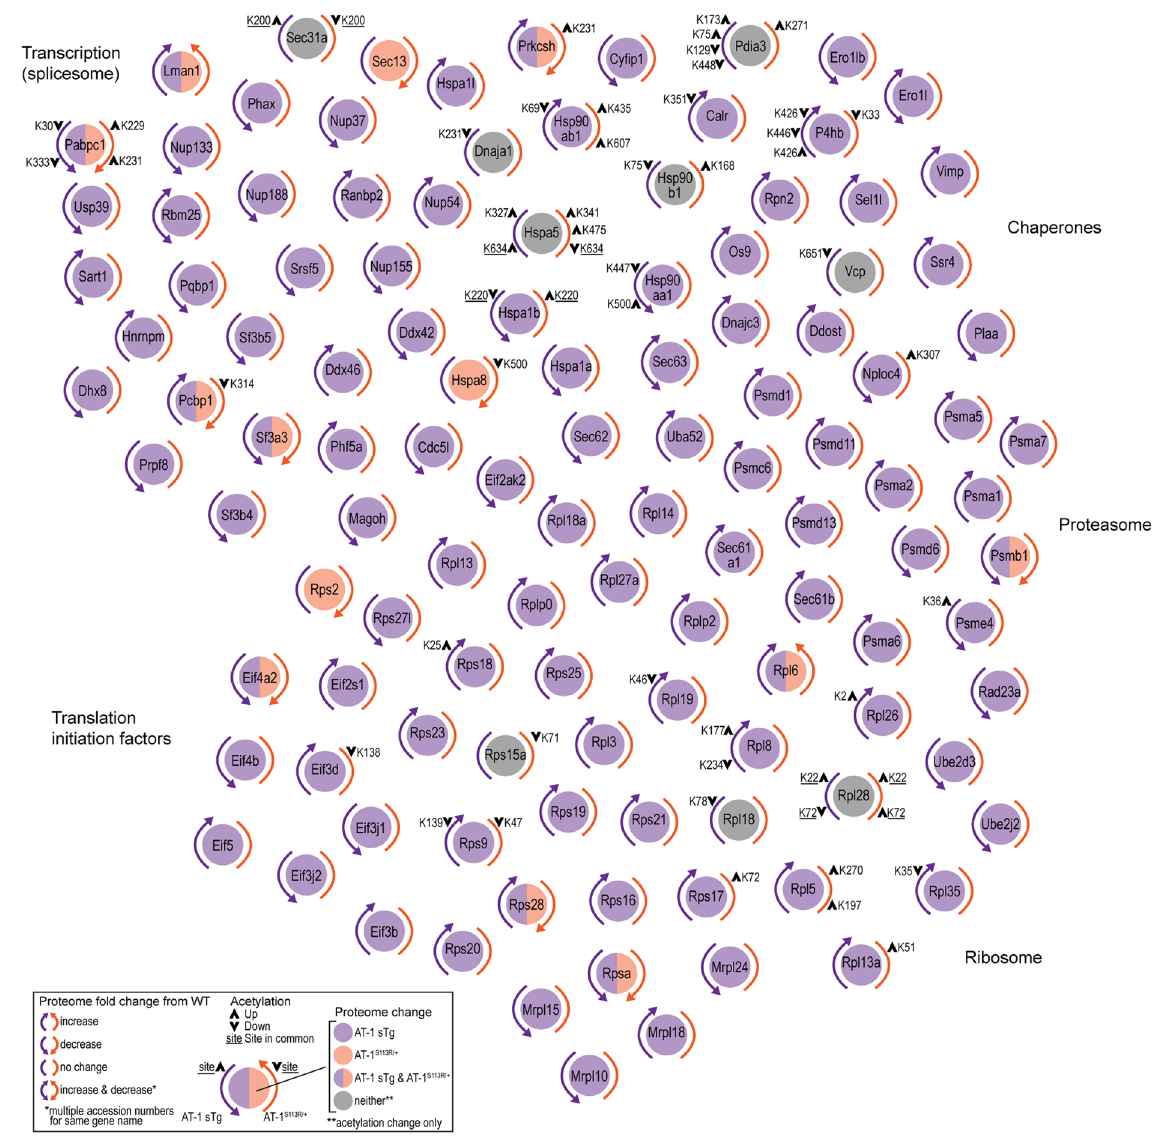
Figure 1. AT-1 sTg and AT-1 S113R/+ display proteomic changes across secretory pathway-related processes. Proteins with significantly changing abundance and acetylation stoichiometry identified across secretory pathway-related KEGG pathways from liver fractions are shown in clusters (n = 4 WT; n = 4 AT-1 sTg; n = 4 AT-1 S113R/+ ). Changes in proteome are indicated by a purple (AT-1 sTg), orange (AT-1 S113R/+ ), or grey (neither proteome changed) circle; corresponding colored arrows indicate increase, decrease, or no change in proteome compared with WT. Acetylation stoichiometry changes are designated with a black arrow on the corresponding AT-1 model in which it changed significantly. If a site changes significantly in both models, the site is